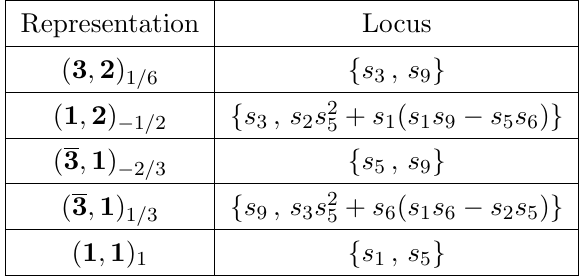
Table 1 . Matter representations of SU(3) (cid:2) SU(2) (cid:2) U(1) appearing in the X F with their associated codimension-two loci. The charge under the U(1) a